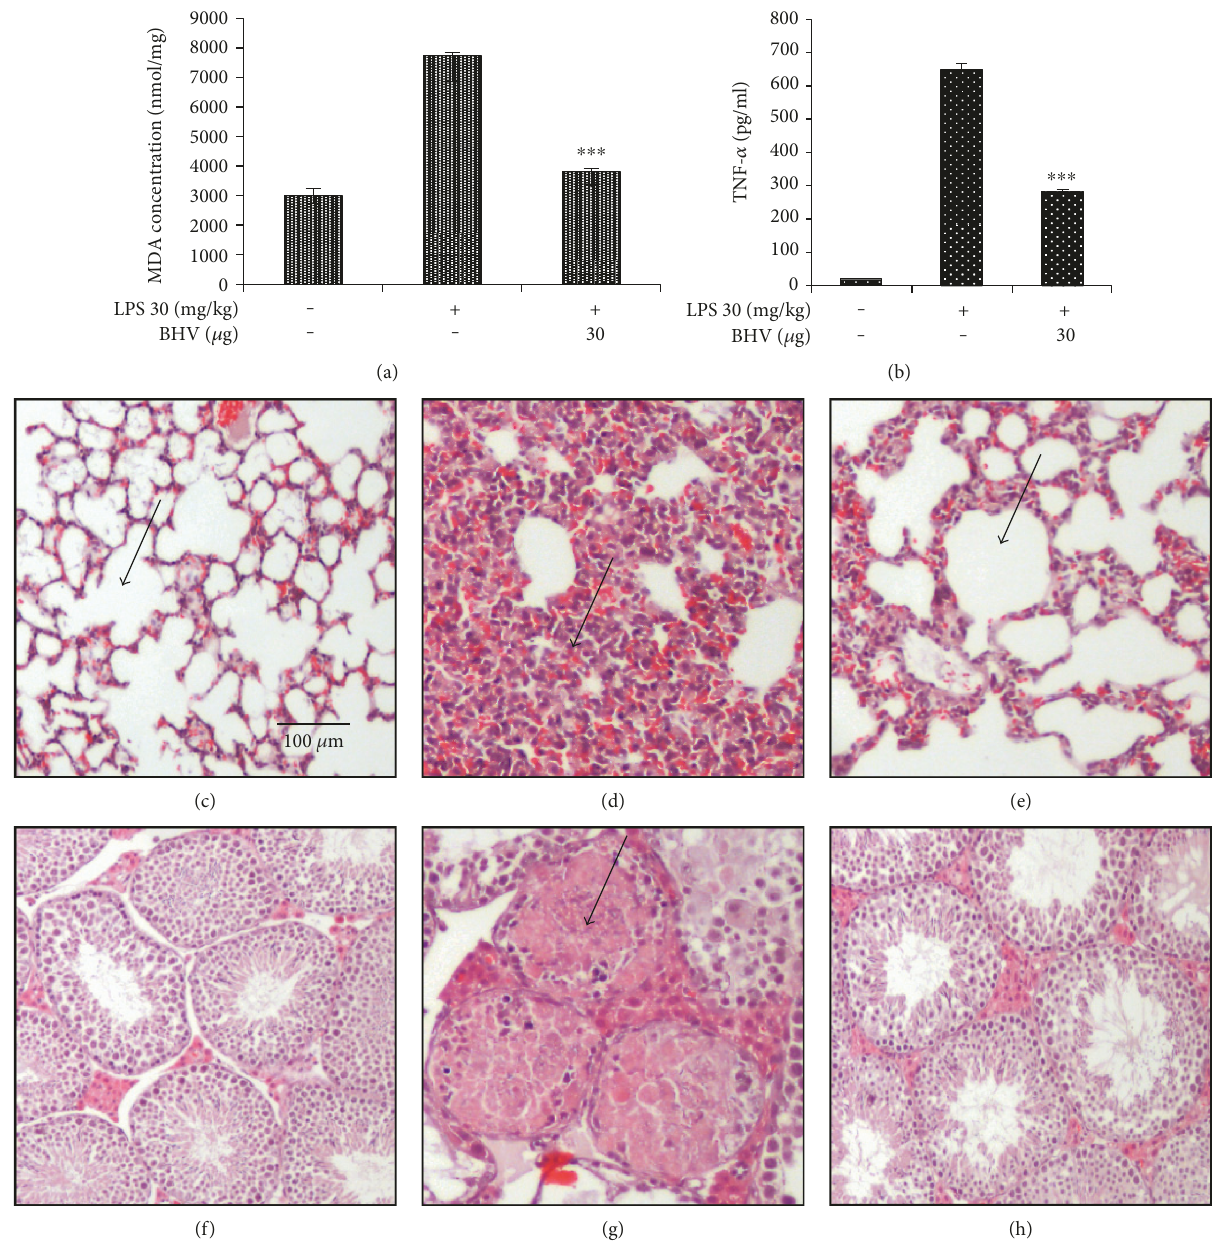
Figure 4: Reduction of serum TNF- α and MDA levels by BHV. For the chronic study of septic shock in mice by LPS, mice were treated with venom for 5 days and then were given the LPS injection. 3 days later, they were euthanized and blood and tissues were collected for TNF- α and MDA levels by commercially available kits. TNF- α levels (a) and MDA levels (b). Values in bar graphs are mean ± SEM of three independent experiments. ∗∗∗ p < 0 001 is considered signi fi cant compared to LPS group only. For hematoxylin and eosin staining, lung and testis tissues were stored in 10% neutral bu ff ered formalin (NBF) and then stained according to standardized protocol for (H&E) staining. Lungs (c – e) and testis (f – h). Scale bar 100 μ